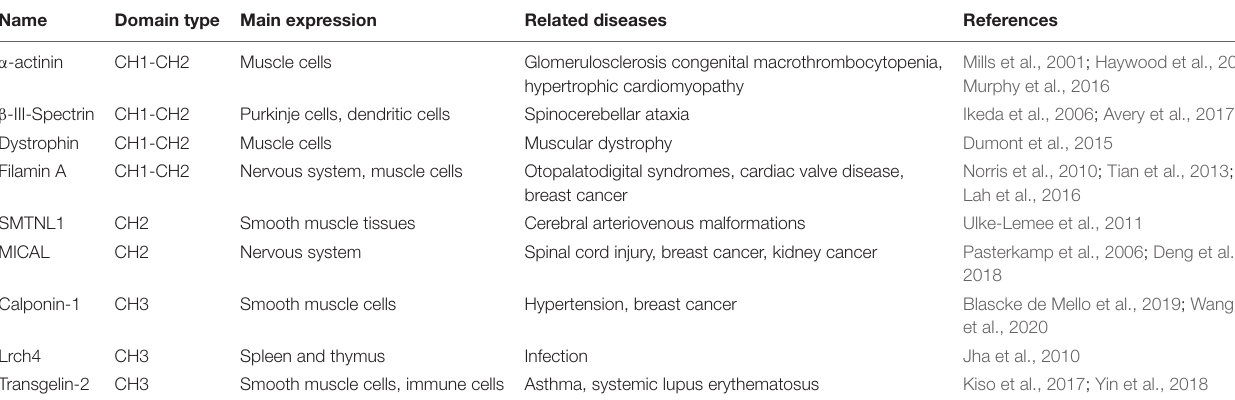
TABLE 1 | CH-domain-containing proteins involved in the onset and progression of different